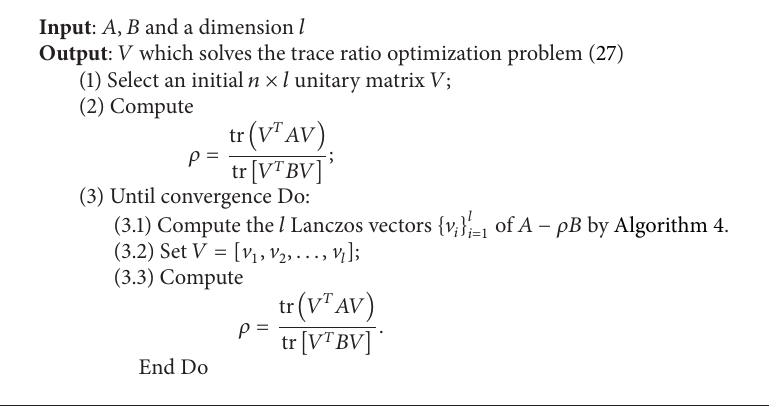
Algorithm 5: Newton-Lanczos method for trace ratio